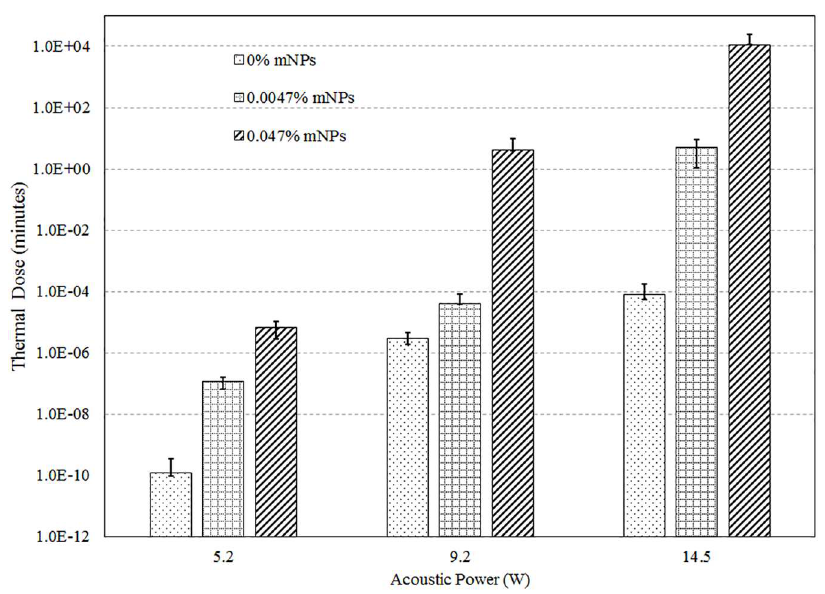
Fig 10. Thermal dose at the focus for 5.2, 9.2, and 14.5 W acoustic powers and 0%, 0.0047%,and 0.047%concentrations of mNPs (Y-axis is in log scale).